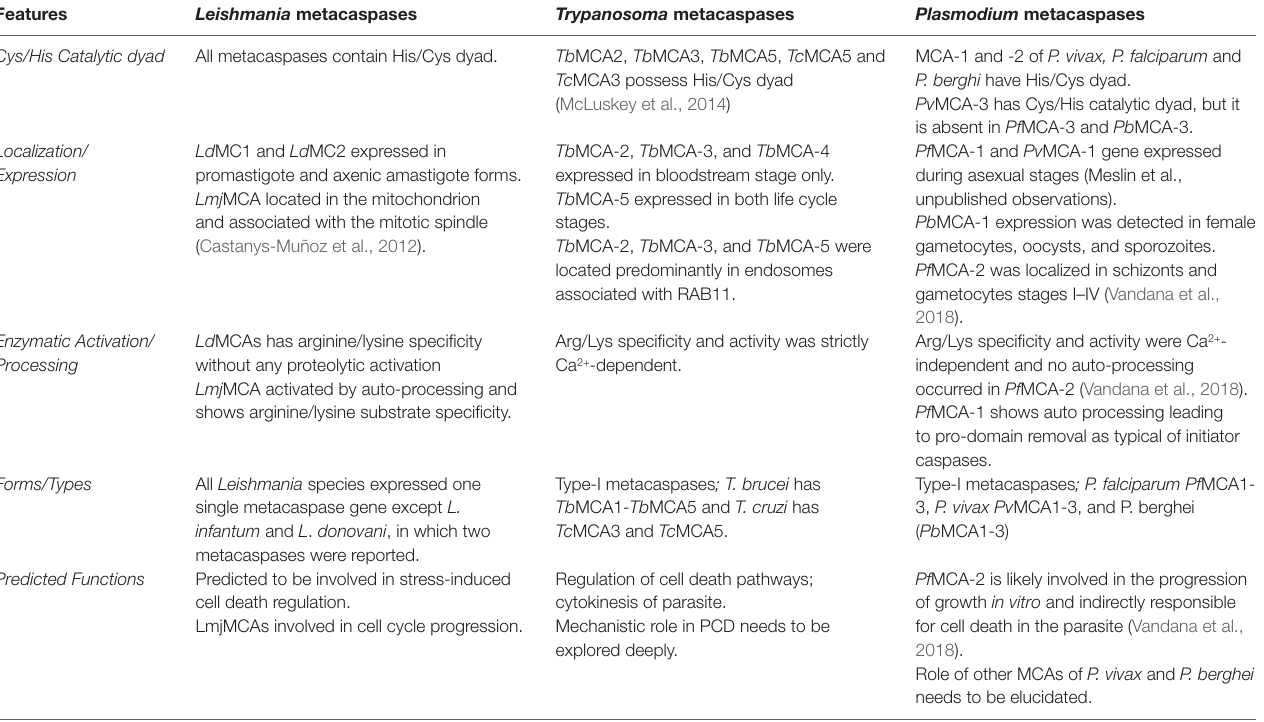
TABLE 3 | Comparative analyses of key features of protozoa